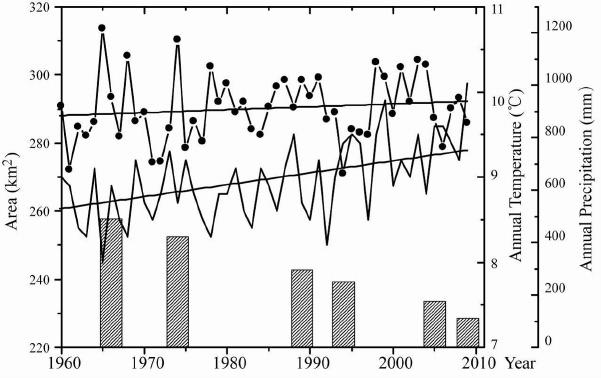
Fig. 8. The relationship between glacier retreat and climate change. Bars show glacier retreat, the black dashed line is mean precipitation and the black solid line is mean temperature.